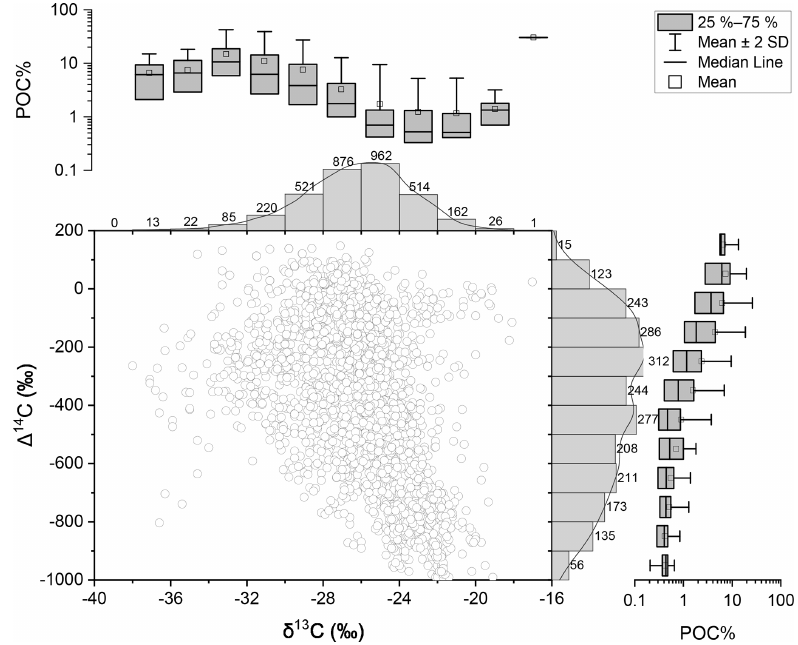
Figure 2. δ 13 C versus (cid:49) 14 C of MOREPOC v1.1 ( n = 2,129). Frequency distribution histograms for δ 13 C ( x axis) and (cid:49) 14 C ( y axis) are shown, with δ 13 C values binned every − 2.5‰ from − 40‰ to − 15‰ and (cid:49) 14 C values binned every − 50‰ from − 1000‰ to 200‰. Each bin is labeled with the number of samples it hosts. Solid lines represent the corresponding probability density functions. Box charts represent the statistical analysis of POC% in each bin of δ 13 C ( x axis) and (cid:49) 14 C ( y axis).